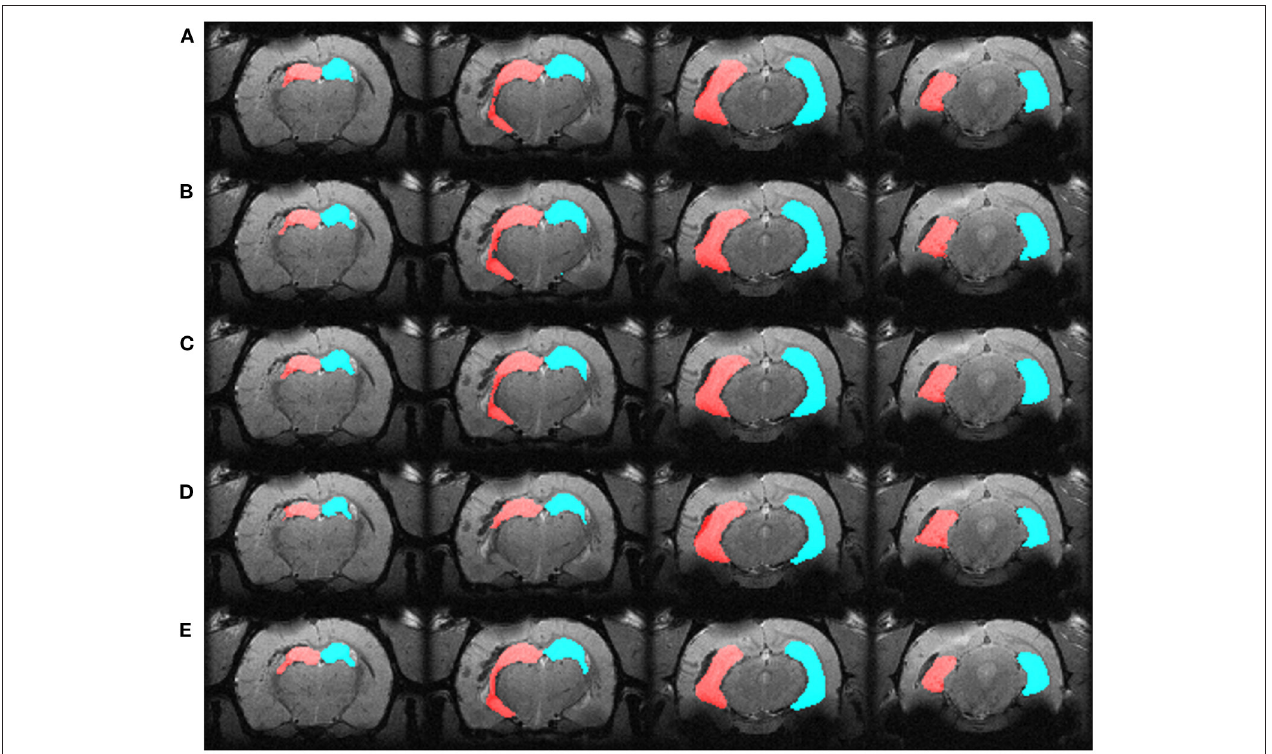
FIGURE 2 | Segmentation maps in four representative slices from a randomly selected animal from the EpiBioS4Rx dataset, at the 2-days timepoint. Segmentation maps were obtained with: (A) MU-Net; (B) STEPS, (C) Majority voting, (D) Single-atlas segmentation. (E) Displays the ground-truth segmentation. From left to right, slices are located at approximately − 2.2, − 3.3, − 5.0, − 6.2mm from bregma. Red: hippocampus ipsilateral to the lesion; blue: hippocampus contralateral to the